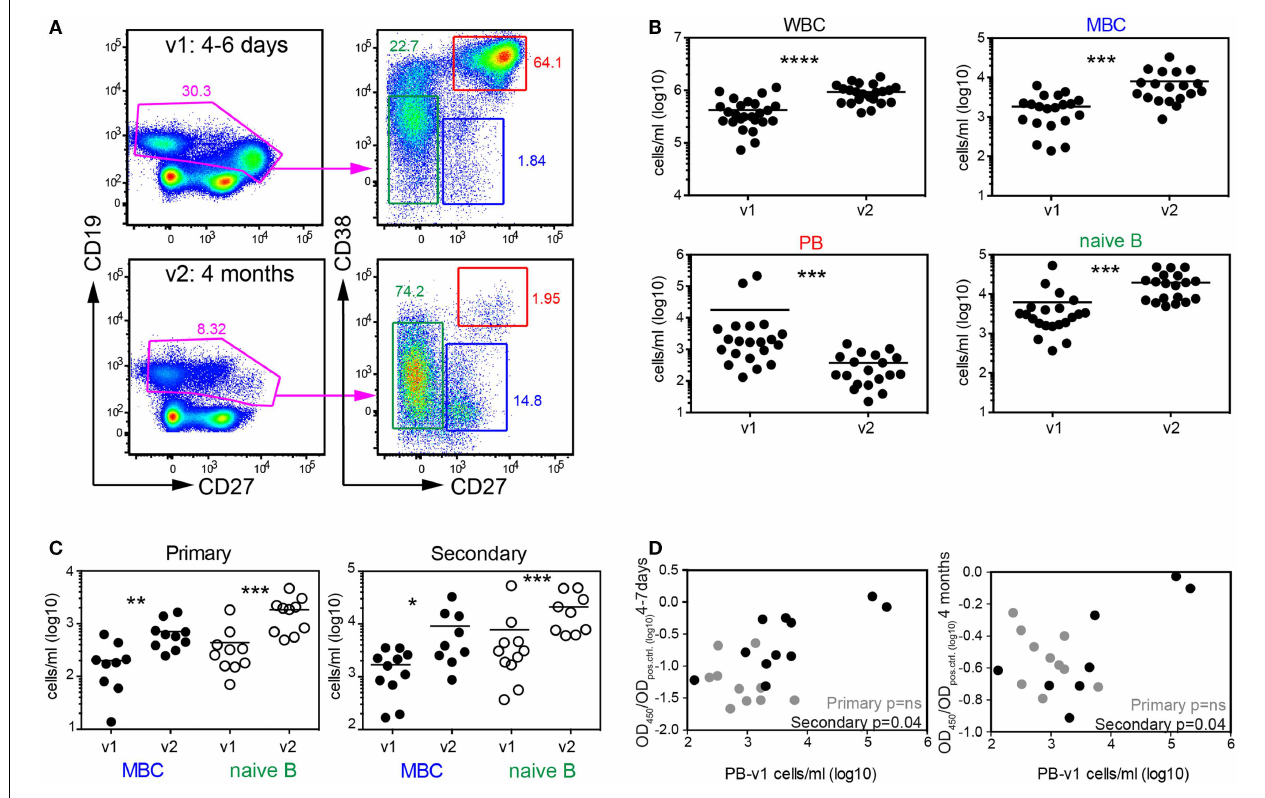
representative patient are shown. (B) Quantification of the cell subsets illustrated in (A) . (C) Data in (B) were separated into patient groups experiencing a primary or secondary infection. (D) Correlation between PB numbers detected at v1 and UV-DENV ELISA OD ratio (OD 450 / OD pos.control ) measured at v1 and v2. (B–D) Each dot represents one patient; * p < 0.05, ** p < 0.01, *** p < 0.001, **** p < 0.0001 (Wilcoxon matched-pairs signed rank